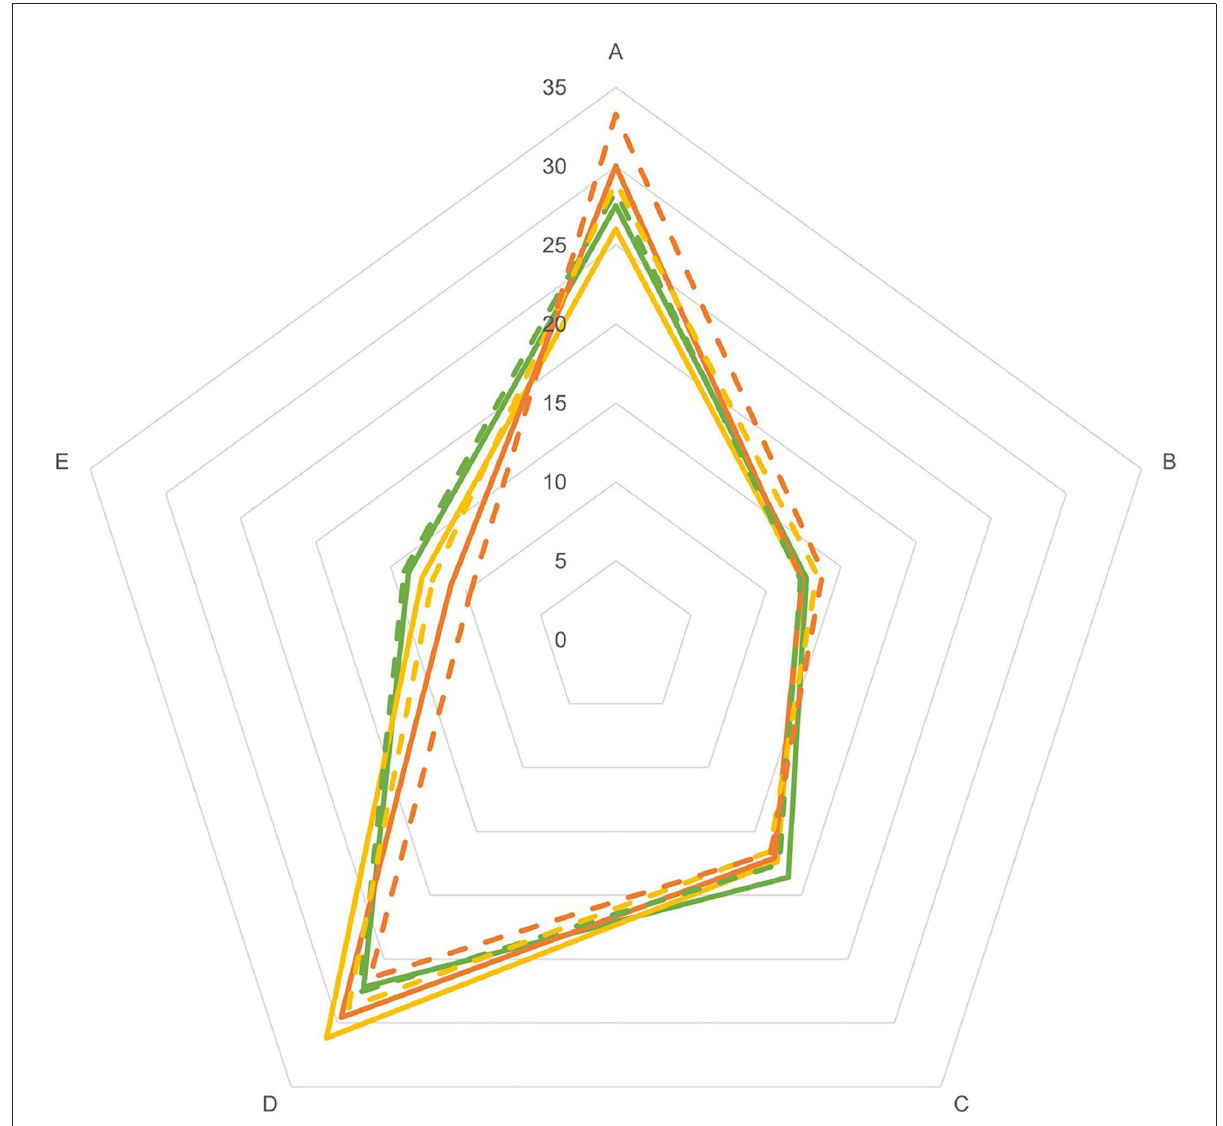
FIGURE1 Nutritional value of European diets according to the Nutri-Score classification, expressed in the share (%) of dietary energy intake from foods and beverages classified as A, B, C, D, and E, stratified by age-group and sex. Adolescent-Males; Adolescent-Females; Adult-Males; Adult-Females; Elderly-Males; Elderly-Females